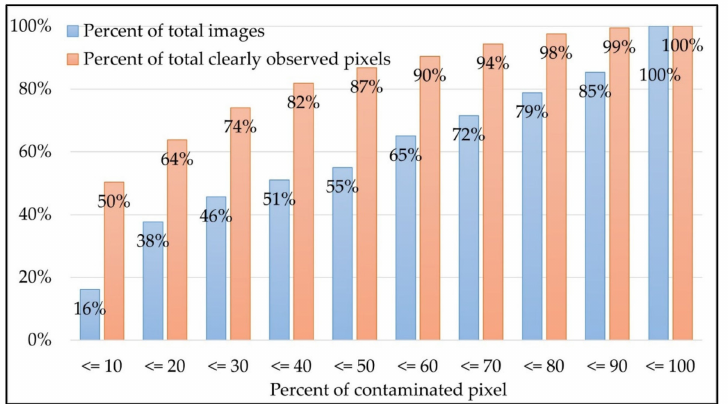
Figure 6. Comparison between the percentage of total images and percentage of total clearly observed